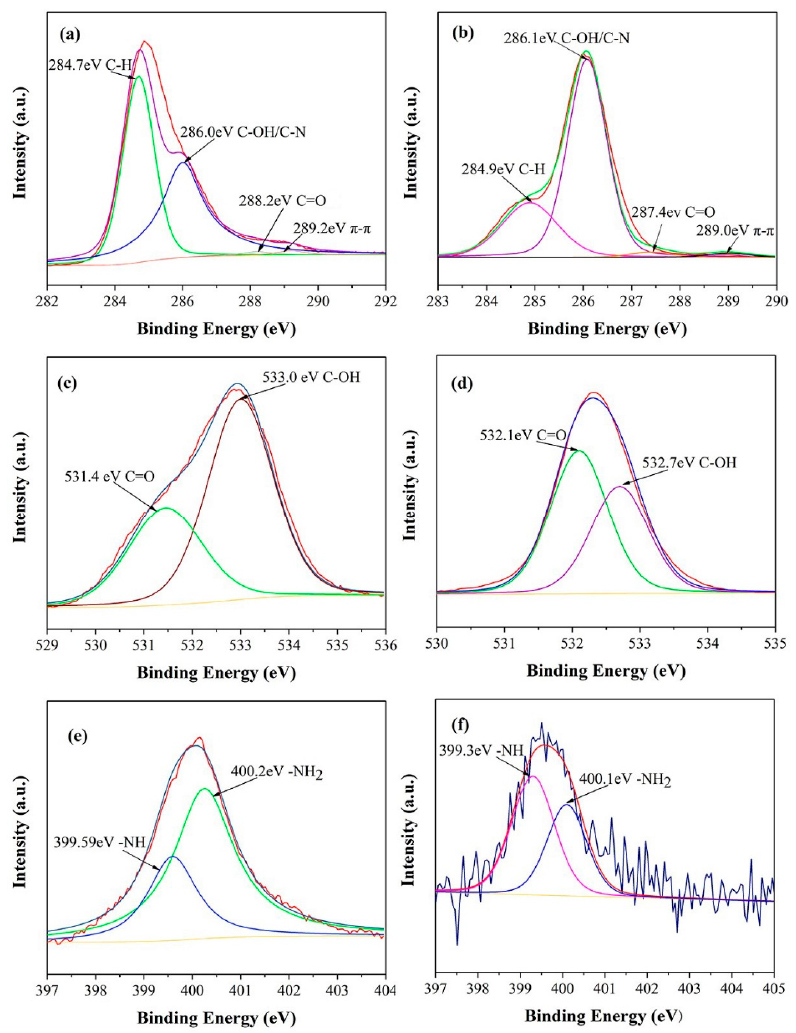
Figure 12. XPS patterns of the PDAMs: ( a ) C, ( c ) O, and ( e ) N, and XPS patterns of 75% PEG / PDAM-3: ( b ) C, ( d ) O, and ( f )